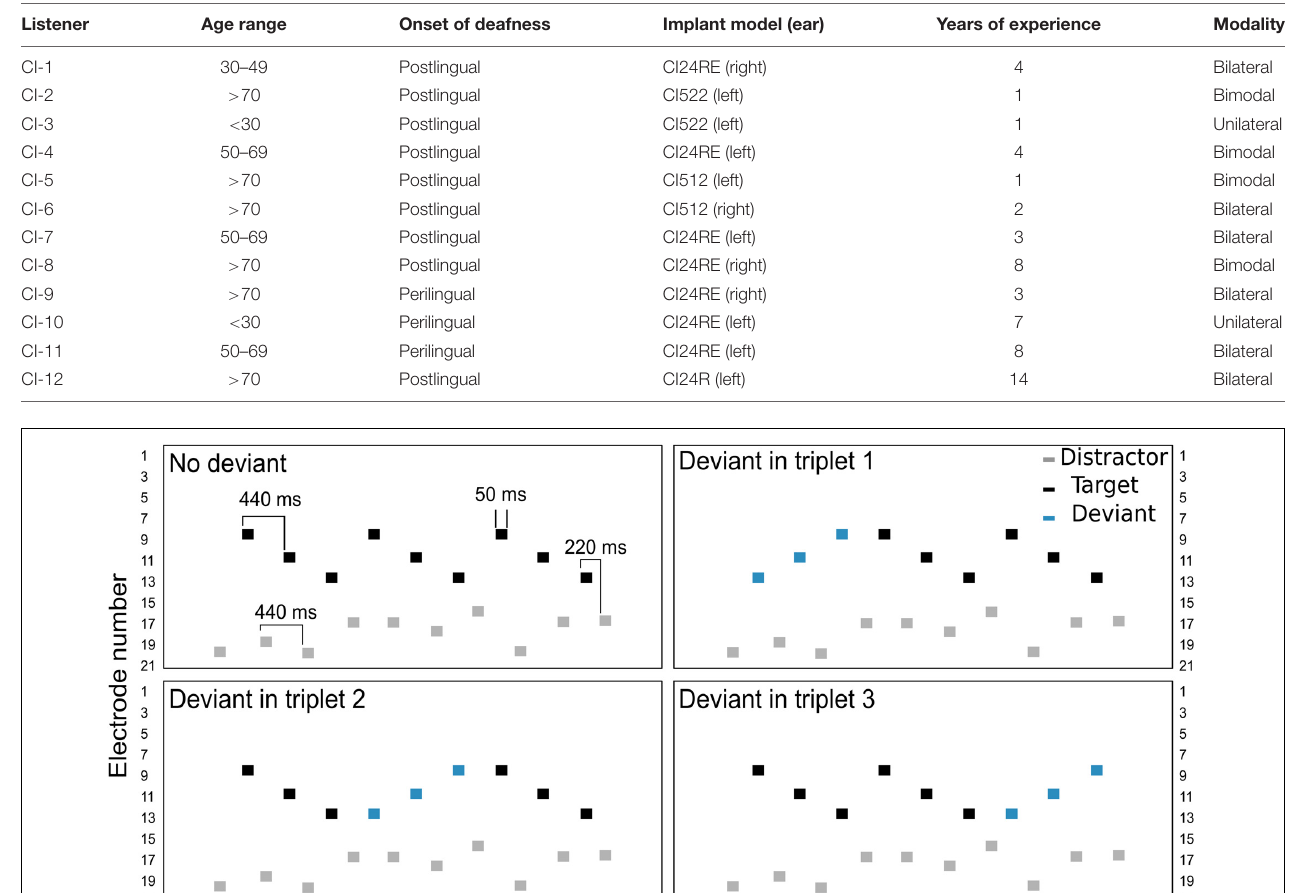
TABLE 1 | Information about the participants regarding age, gender, onset of deafness, implanted ear, number of years of experience and modality of rehabilitation.